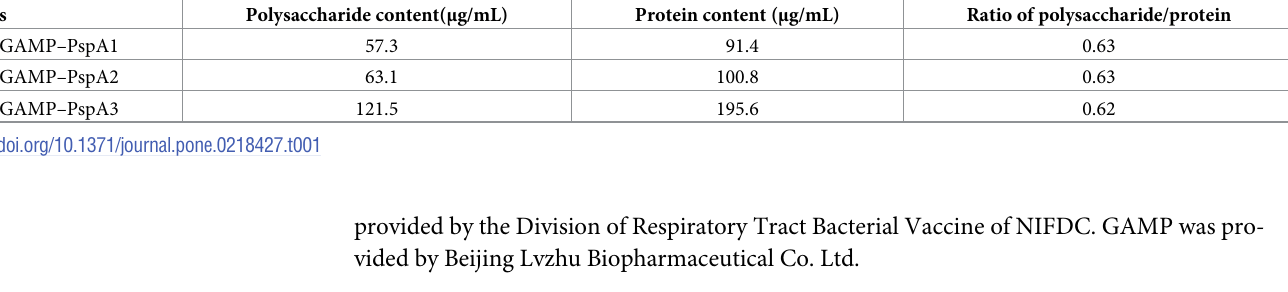
Table 1. Ratios of polysaccharides to proteins for GAMP–PspA conjugates.